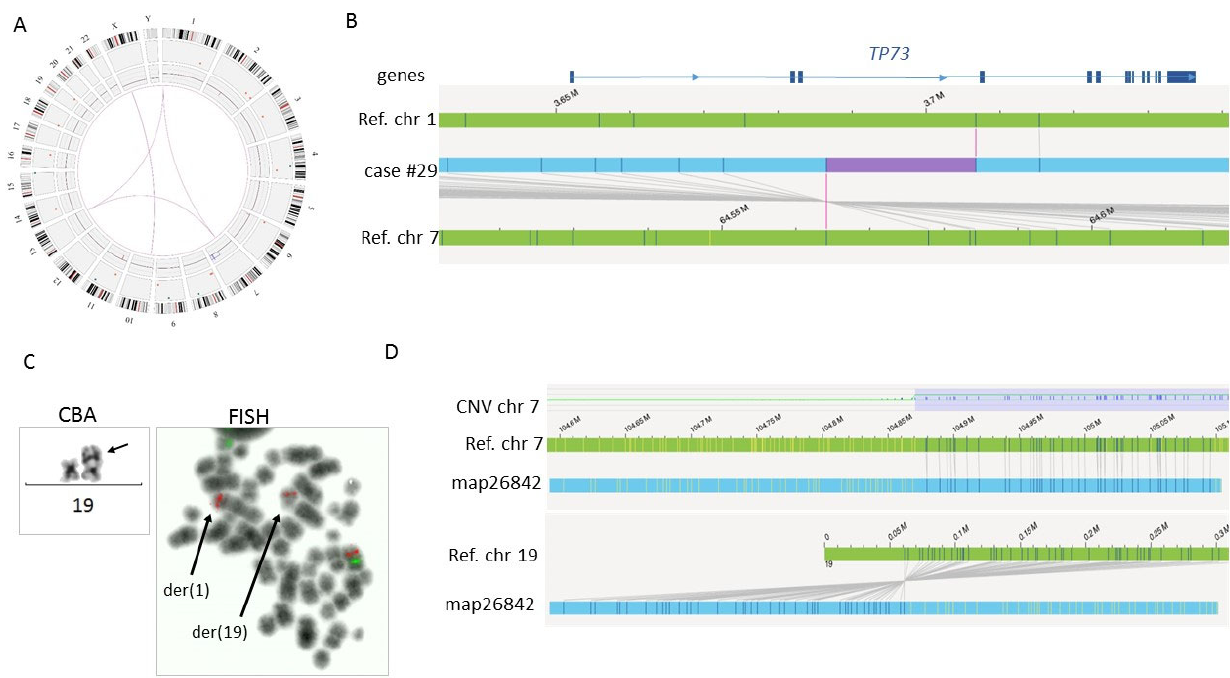
Figure 3. OGM results for case #29. ( A ) Circos plot showing t(X;10) and CNV gain of the long arm of chromosome 7 and showing that t(1;7) initially described on karyotype is actually a three-way translocation involving a chromosome 13. The translocation of the extra copy of chromosome 7q to chromosome 19 described by CBA and FISH was not automatically detected by OGM. ( B ) Schematic representation of the alignment of a genomic map corresponding to the translocation between chromosomes 1 and 7 showing that the breakpoint at chromosome 1 disrupts the TP73 gene between introns 1 and 3 (blue box represents exons). ( C ) Detail of CBA (×60) showing the der(19) with additional material on the short arm. FISH (×100) with LSI D7S486 probe (Abbott) in red and control centromeric probe in green showed three spots for LSI D7S486: on the normal chromosome 7 with control probe, on der(1), and der(19). ( D ) Schematic representation of the alignment of genomic map 26,842 showing a match with the reference genome map of chromosome 7 at the limit of the CNV gain and with the reference genome map of chromosome 19 at the telomeric end of the short arm. CNV = copy number variation. der =